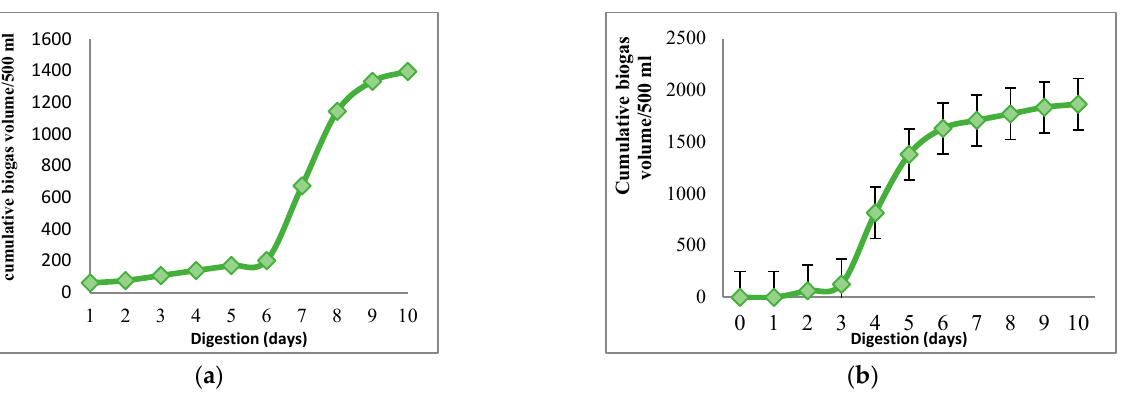
Figure 16. Cumulative biogas produced for digester at HRT= 15 ( a ) and HRT = 20 ( b ) at. T = 37 °C, pH = 7 with digestion time of 10 days and digester volume of 500 mL.